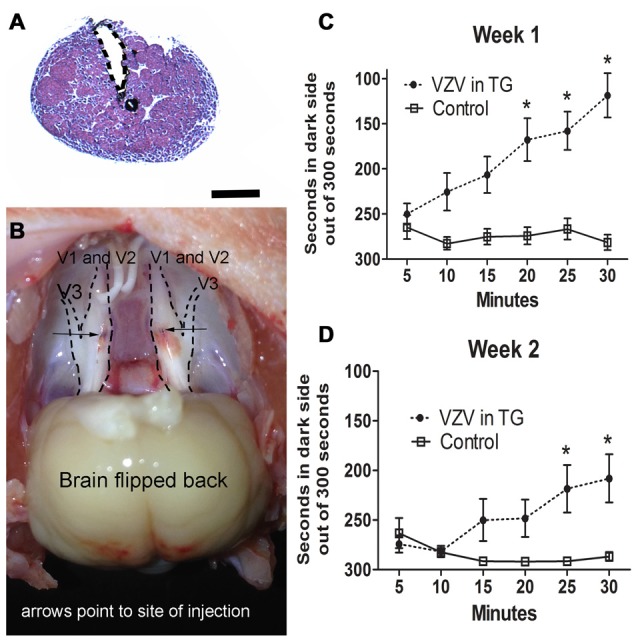
Experiment 1, the affective pain increased after injection of varicella zoster virus (VZV) into the trigeminal ganglion. (A) shows a hematoxylin eosin stained coronal section of the trigeminal ganglion after stereotaxic injection of India ink (black). The needle injection site is marked by a dotted line. Bar = 1 mm. In (B) a gross dissection of a rat head is shown with the trigeminal ganglion exposed after bilateral stereotaxic injection with India ink (arrows point to the black India ink spots). V1, V2 and V3 refer to the different branches of the trigeminal ganglion. Place escape avoidance paradigm (PEAP) behavioral measurements were completed weekly, (C) is 1 week after VZV was injected into the trigeminal ganglion and (D) is the second week after VZV was injected into the trigeminal ganglion. Asterisk indicates a significant difference of p < 0.05. The values are the mean ± standard error of the mean (SEM). There were 11 animals in the control group and 17 animals in the VZV treatment group.